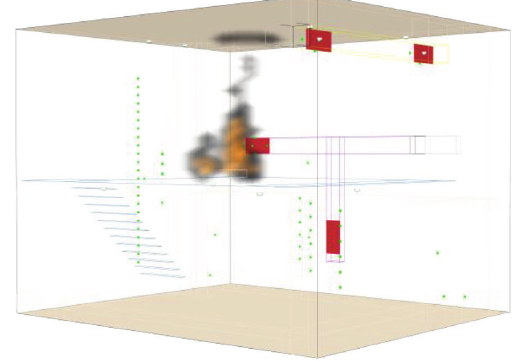
Figure 2: Snapshot of the compartment layout by